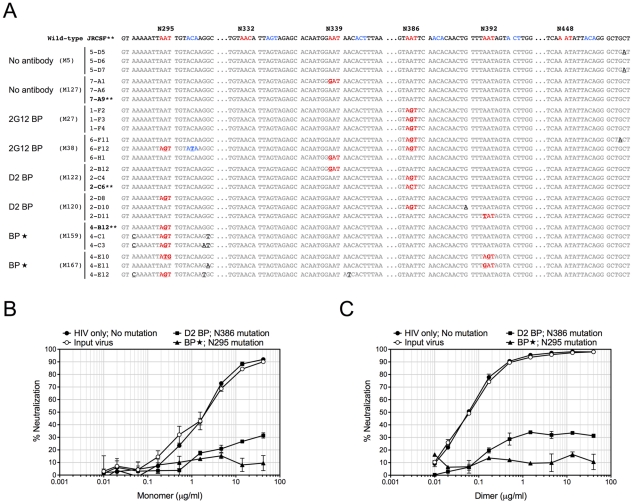
Sequence changes in HIV-1 envelopes and antibody escape.(A) Mouse-derived HIV-1 envelope sequences (regions of interest). Viral RNA was extracted from mouse plasma 4 weeks after HIV-1 challenge, reverse transcribed, and sequenced as described in Materials and Methods. The HIV-1 envelope sequences cloned from mice were aligned to the wild-type JRCSF envelope sequence. The percentages of viral clones with mutations are shown in Table 2. Three sequences from two representative mice of each group are shown in this panel, with the mouse number shown in parentheses. The sequence numbers are also shown next to the sequences. For better viewing, all relevant Asn codons (N295, N332, N339, N386, N392, N448) and their adjacent Ser/Thr codons with mutations are shown in red and blue, respectively, except for the wild-type JRCSF sequence where the wild-type codons are colored. The mutated nucleotides are also bolded and underlined. Some nucleotides other than those that form the carbohydrate anchors were also mutated and they are in black color and underlined. (B) Antibody escape. Four representative envelope genes (labeled with ** in panel A) were subcloned into an expression plasmid for the in vitro neutralization assay. The viral envelope from a D2 BP mouse had a single mutation of N386T. This mutation also occurred in 2G12 BP mice. The viral envelope from a BP mouse had a mutation of N295S. The viral envelope from an HIV-1-only mouse contained no mutations. The envelope of the virus injected to mice (the input virus) was used as the control. Pseudoviruses were made from these envelopes and in vitro neutralization assay was performed. Neutralization of pseudoviruses by the 2G12 monomer is shown in this panel. (C) Pseudoviruses were made and in vitro neutralization assay was performed as described in panel B. Neutralization of pseudoviruses by the 2G12 dimer is shown in this panel.